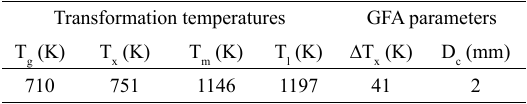
Figure 5: Thermal analysis of Zr-Co-Al-Ag BMG, with a D Table 2: Transformation temperatures and GFA parameters of the Zr